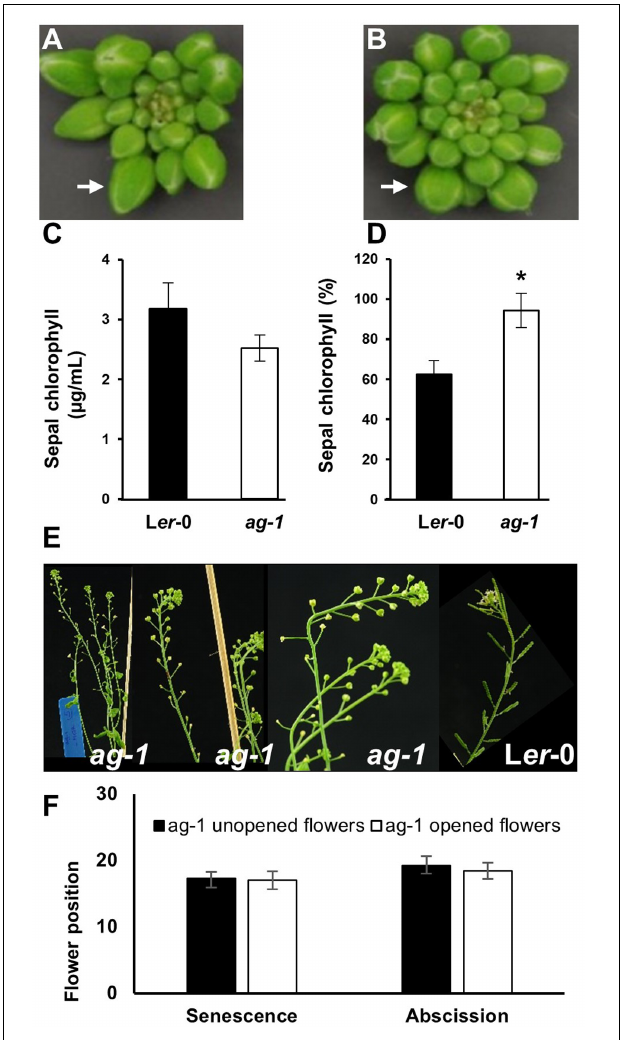
FIGURE 2 | Sepal Yellowing of ag-1 and L er -0 flowers. (A) L er -0 inflorescence. (B) a g-1 inflorescence. (C) Chlorophyll concentration of L er -0 and ag-1 sepals obtained from outermost buds. (D) Percentage chlorophyll of L er -0 and ag-1 sepals at flower position 2 (indicated by white arrows in Figures 1C,D ) compared with that in sepals from unopened flowers of the outer whorl shown here in (A,B) , indicated by white arrows. Sepal chlorophyll percentage was calculated by comparing the chlorophyll concentration of sepals from flowers at position 2 to that in sepals from unopened flowers. Plants were grown under long-day conditions for 8 weeks as described in Section Materials and methods. (E) 8-week-old ag-1 plants with un-opened flowers. (F) Position of flowers showing yellowing and abscission in 8 week-old- ag-1 plants with opened and un-opened flowers. 8-week-old ag-1 plants with un-opened flowers were grown in a growth chamber with16-h-light/8-h-dark cycle, 100 µ mol m − 2 s − 1 white light, and 60% relative humidity. The flowers are numbered according to the numbering system of Bleecker and Patterson (1997). The error bars indicate standard error of the means of six biological replicates. ∗ Indicates statistically significant ( p < 0.05 ) between the wild type (L er -0) and ag-1 using Student’s t -test.